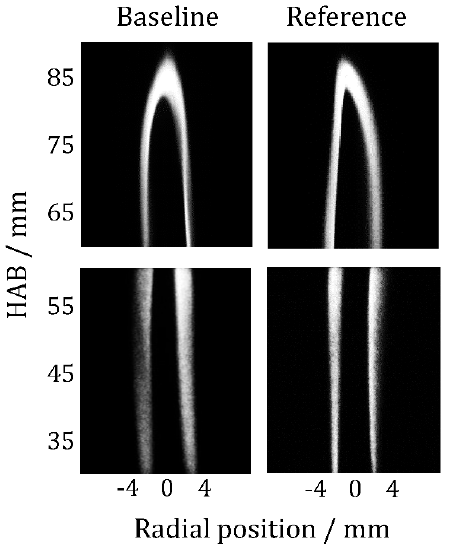
Figure 5. Single-shot raw LII images of the laminar non-premixed flame obtained from the combustion of the reference and the baseline diesel.